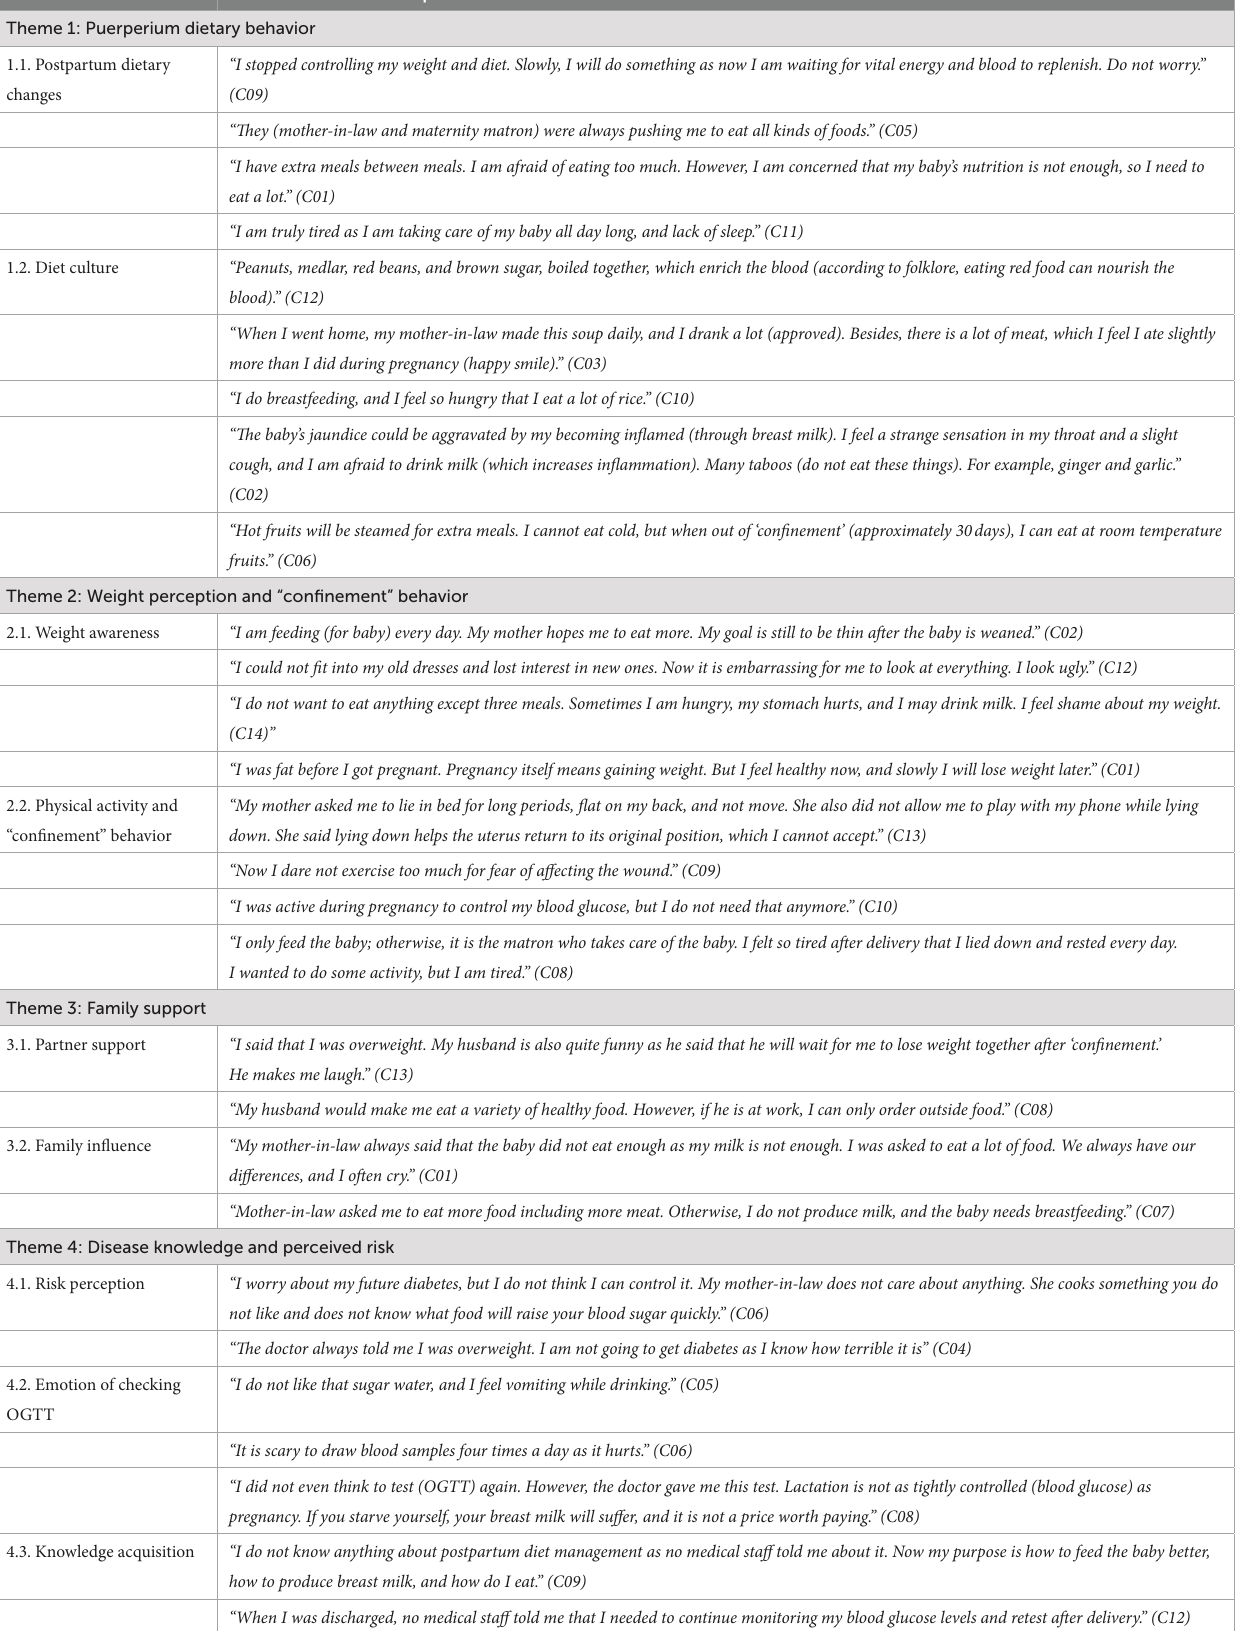
TABLE 2 The overview of themes, sub-themes, and quotes of women with recent GDM and overweight/obesity during puerperal experience and lifestyle. Theme subtheme Selected relevant